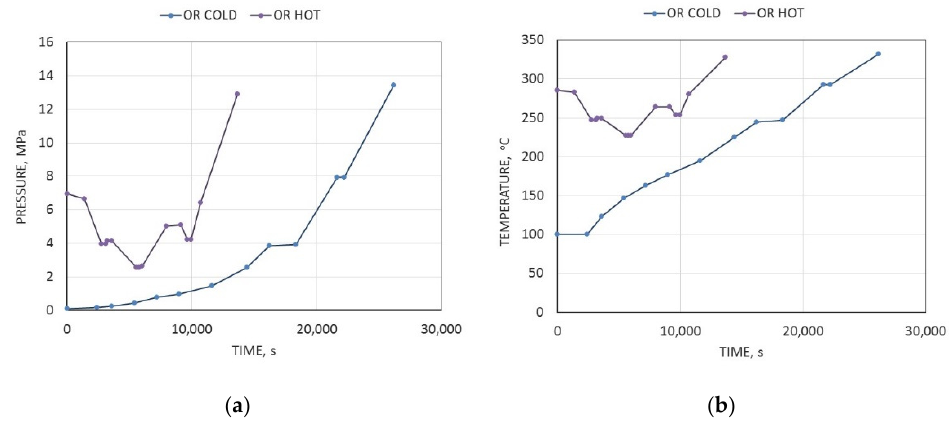
Figure 2. Changes in ( a ) steam pressure and ( b ) temperature within a drum under cold startup operation (OR COLD) and hot startup operation (OR HOT), when subjected to real industrial conditions.